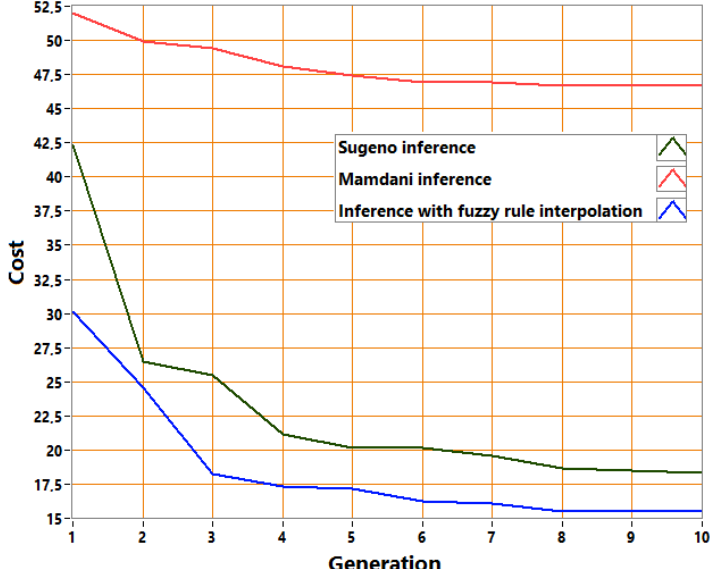
Figure 18. Cost function decrease in the case of different inference methods.